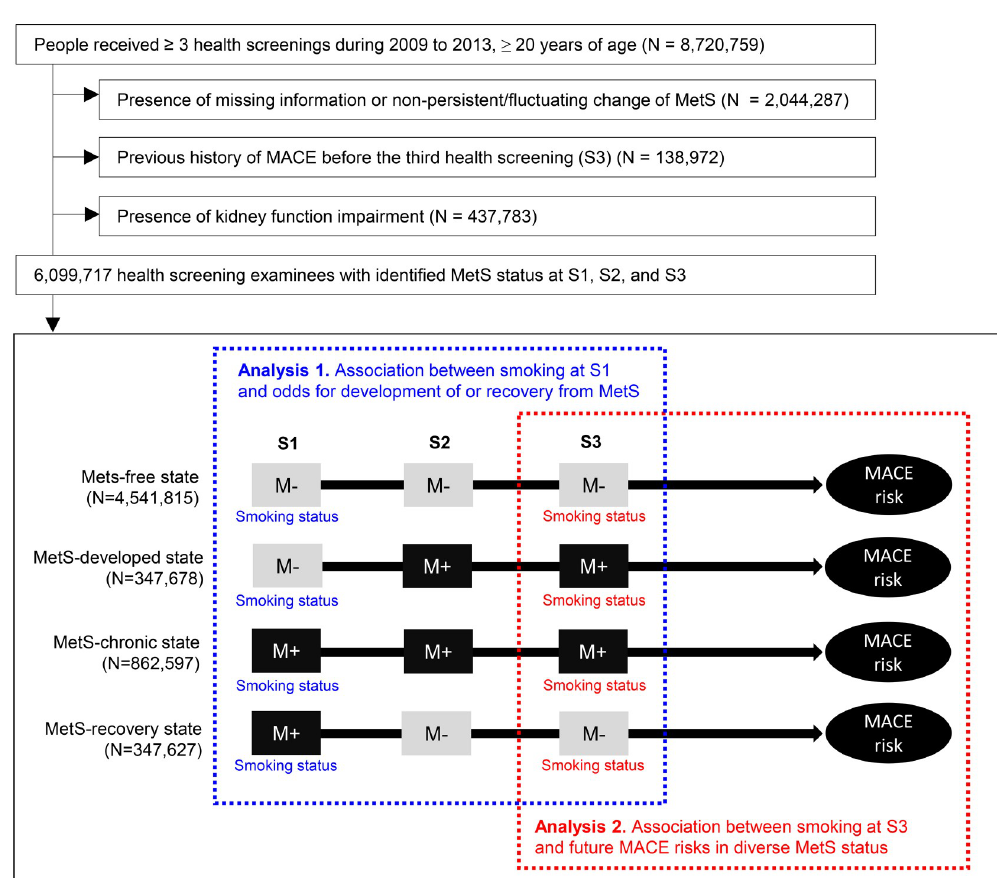
Fig 1. Study population. The flow diagram for the study population. The first three health screenings are indicated as S1, S2, and S3. The gray squares with “M–” indicate a health screening without identified metabolic syndrome MetS. Black squares with “M+” indicate a health screening with identified MetS. The first part of the study was performed with the smoking status at S1 used as the exposure variable and change in MetS status between S2 and S3 compared to S1 as the outcome variable. The second part of the study was performed with smoking status at S3 used as the exposure variable and future risk of MACE used as the outcome variable. MetS = metabolic syndrome, MACE = major adverse cardiovascular